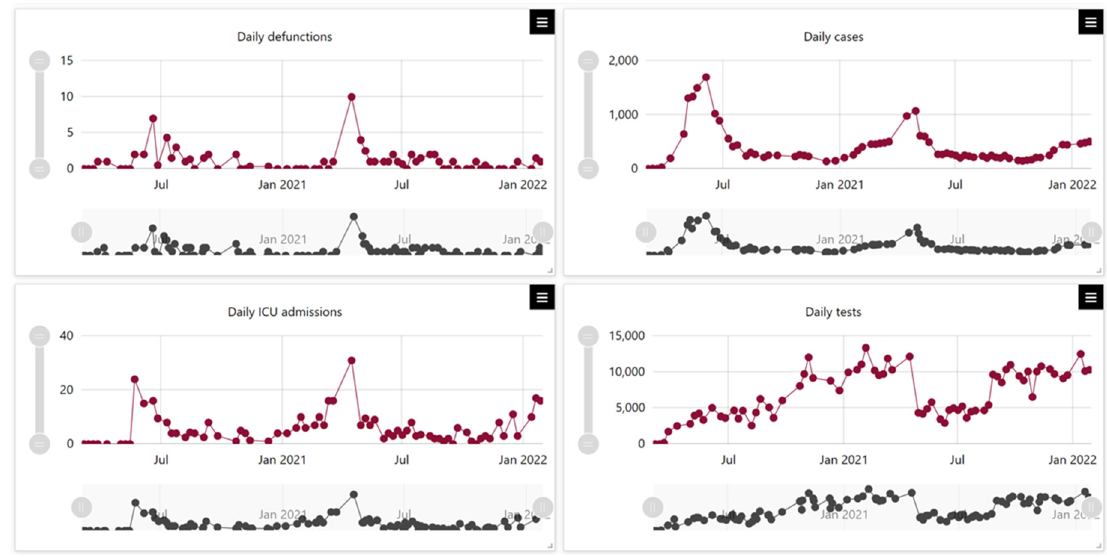
Figure 6 . Example of indicators of COVID19 pandemic evolution .